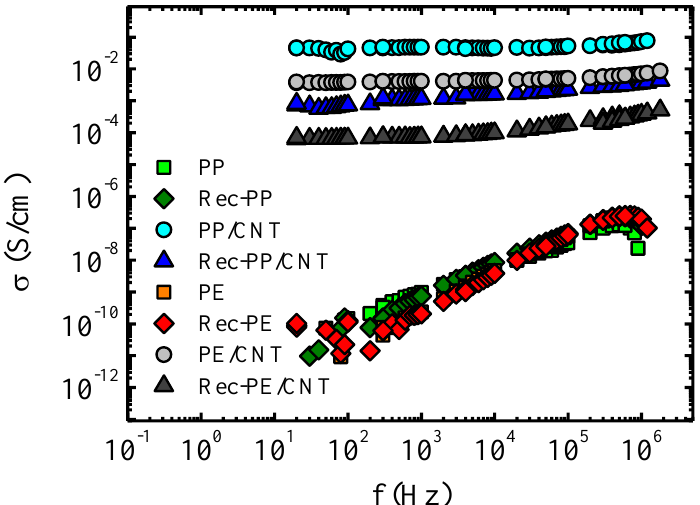
Figure 4. Electrical conductivity as a function of frequency for PP- and poly(ethylene) (PE)-based samples at room temperature.